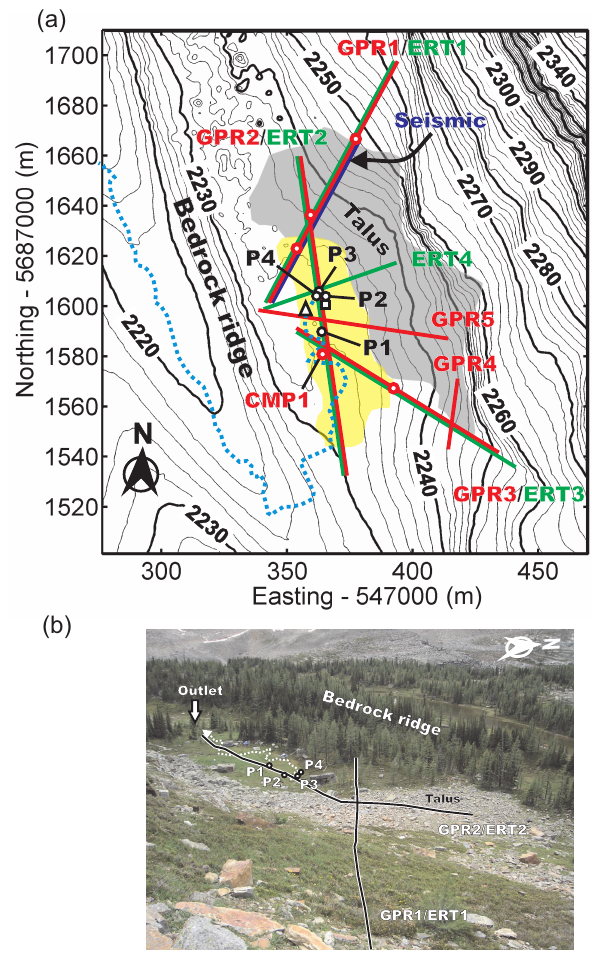
Fig. 3. (a) Contour map of the same region shown in Fig. 2 with location of the five GPR profiles (red lines), centers of five common-midpoint (CMP) GPR profiles (red circles), four ERT pro- files (green lines), and the shot and receiver array of the seismic refraction profile (dark blue line). Yellow body shows the area of the alpine meadow and gray body the area of the talus cones. Also shown are the locations of four piezometers (black circles), the monitoring weir (triangle), and the excavated soil pit (square). Blue dotted line – course of the small stream. Contour elevations are in meters. (b) Photo of the talus-meadow complex taken from the top of profile GPR1/ERT1 and looking to the southwest. Also shown are the locations of piezometers P1-P4 and profile